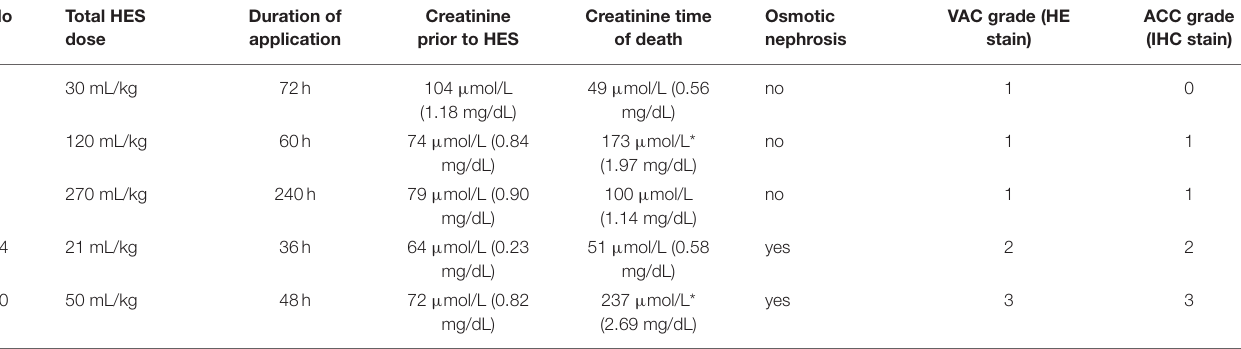
TABLE 3 | Plasma creatinine concentrations pre- and post-HES, cumulative HES dose, duration of application, and histopathological results in 5/20 dogs. No Total HES dose